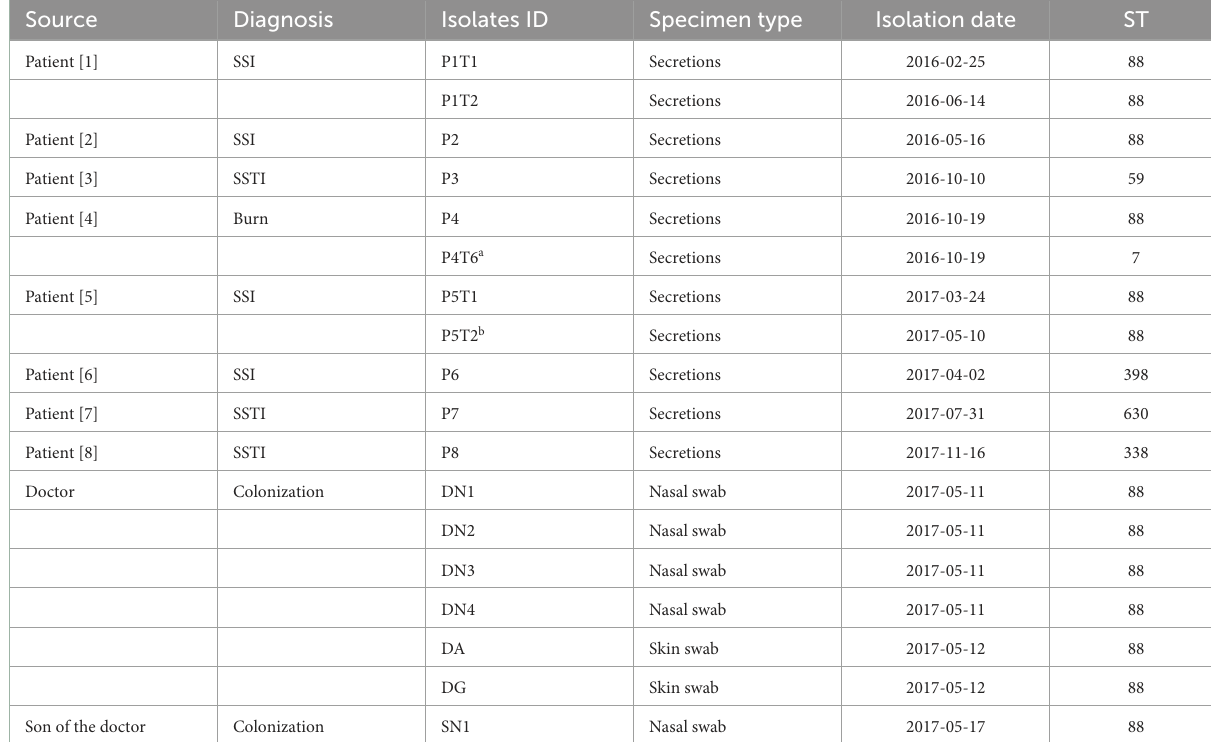
a SimultaneousisolationofMRSAandMSSAfrompatient4.Therelationshipbetweenthesetwostrainswasevaluatedbysequencing.P4T6wasMSSA.SSTI,skinandsofttissueinfection. b